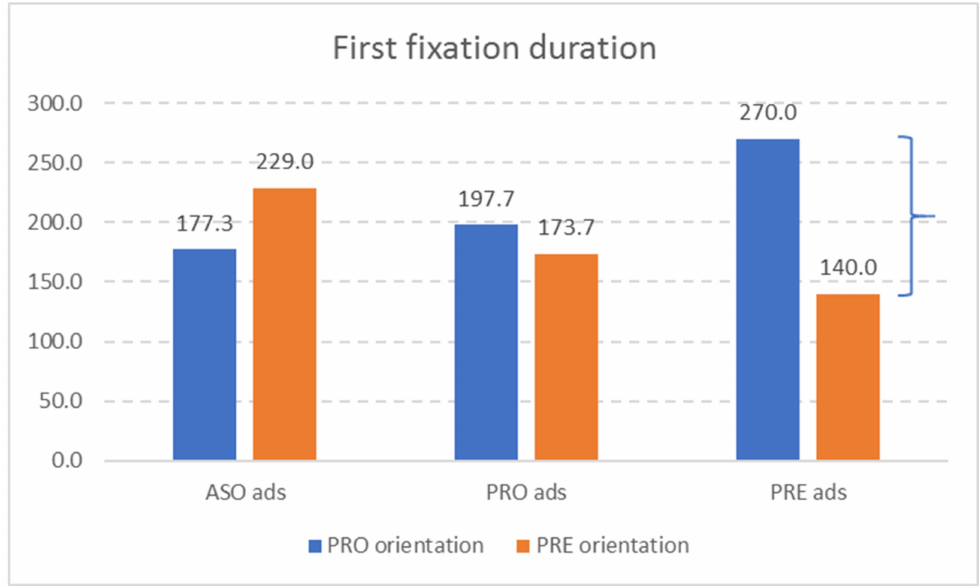
Figure 9. Mean graph for FFD and ad type vs. regulatory orientation (in ms).